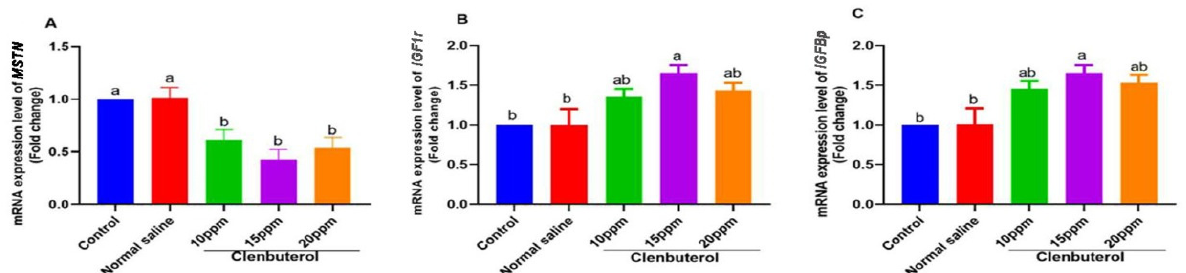
Animals 2021 , 11 , x FOR PEER REVIEW 10 of 18 Figure 1. Expression of fold changes of Muscular ( A ) MSTN , Myostatin gene, ( B ) IGF1R , insulin growth factor1 receptor, ( C ), IGFBP2 , Insulin-like growth factor-binding protein 2. Data Mean ± SE were analyzed with one-way ANOVA followed by Duncan’s multiple comparison test. Columns with differ superscripts (a, b, c, d) differ significantly ( p < 0.05).